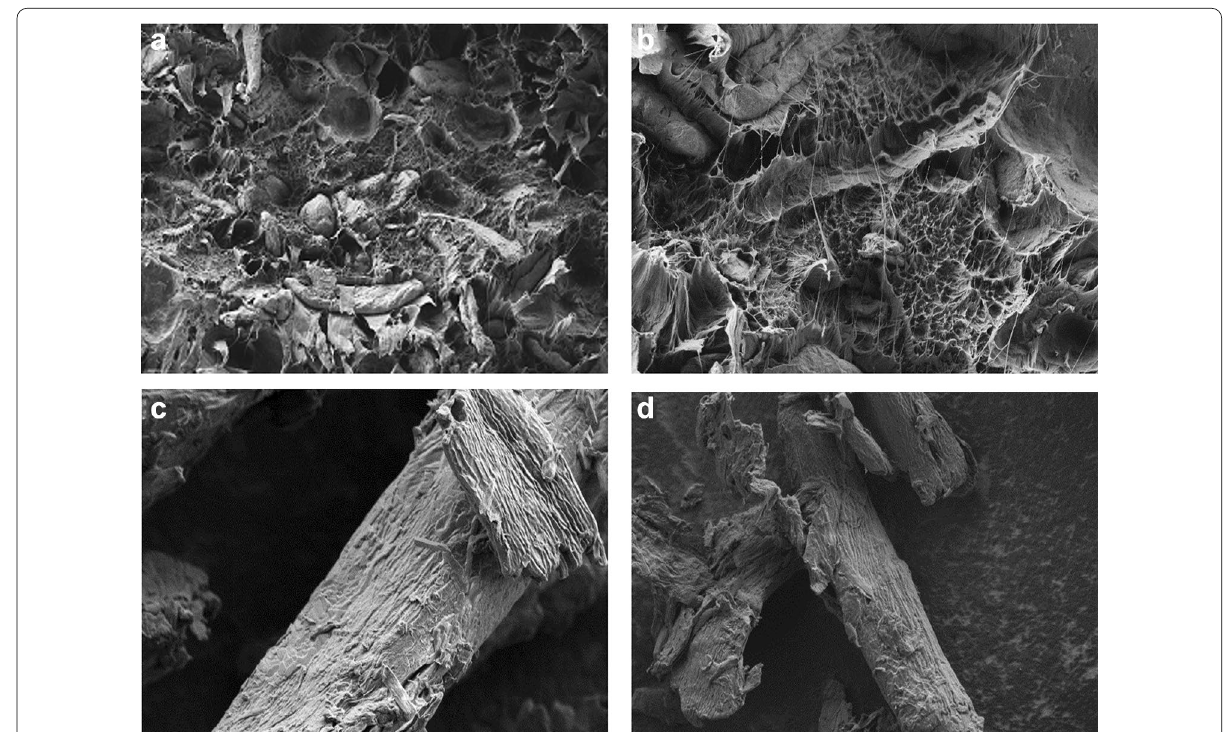
Fig. 2 SEM of a 25% US-PEC/PP, b 25% AUTO-PEC/PP (reproduced from Abdullah et al. 2016b, with permission from Elsevier), c US-PEC-EDTA modified, d AUTO-PEC-EDTA modified (reproduced from Nazir et al. 2018a,